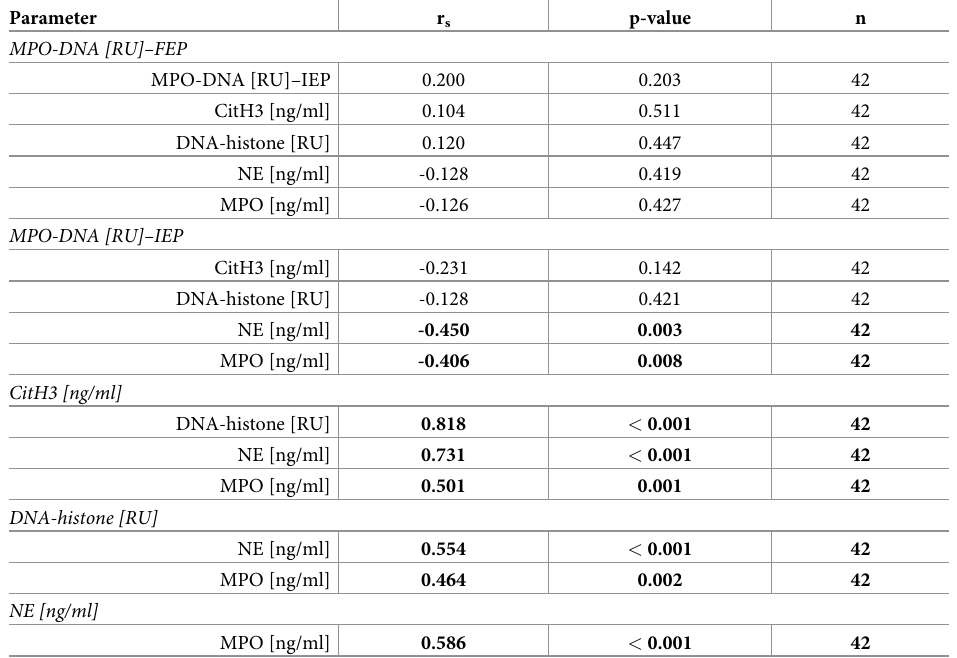
NE [ng/ml] 0.586 < 0.001 42 CitH3, citrullinated histone H3; DNA, deoxyribonucleic acid; FEP, final ELISA protocol; IEP, initial ELISA protocol; MPO, myeloperoxidase; NE, neutrophil elastase; r s , Spearman’s coefficient of correlation; RU, relative units. CTAD plasma samples of seven healthy volunteers at baseline and at various time points after LPS administration were assessed for MPO-DNA complexes (by the initial as well as the final ELISA protocol), NE, MPO, DNA-histone complexes and citH3. Correlation between parameters is expressed by Spearman’s